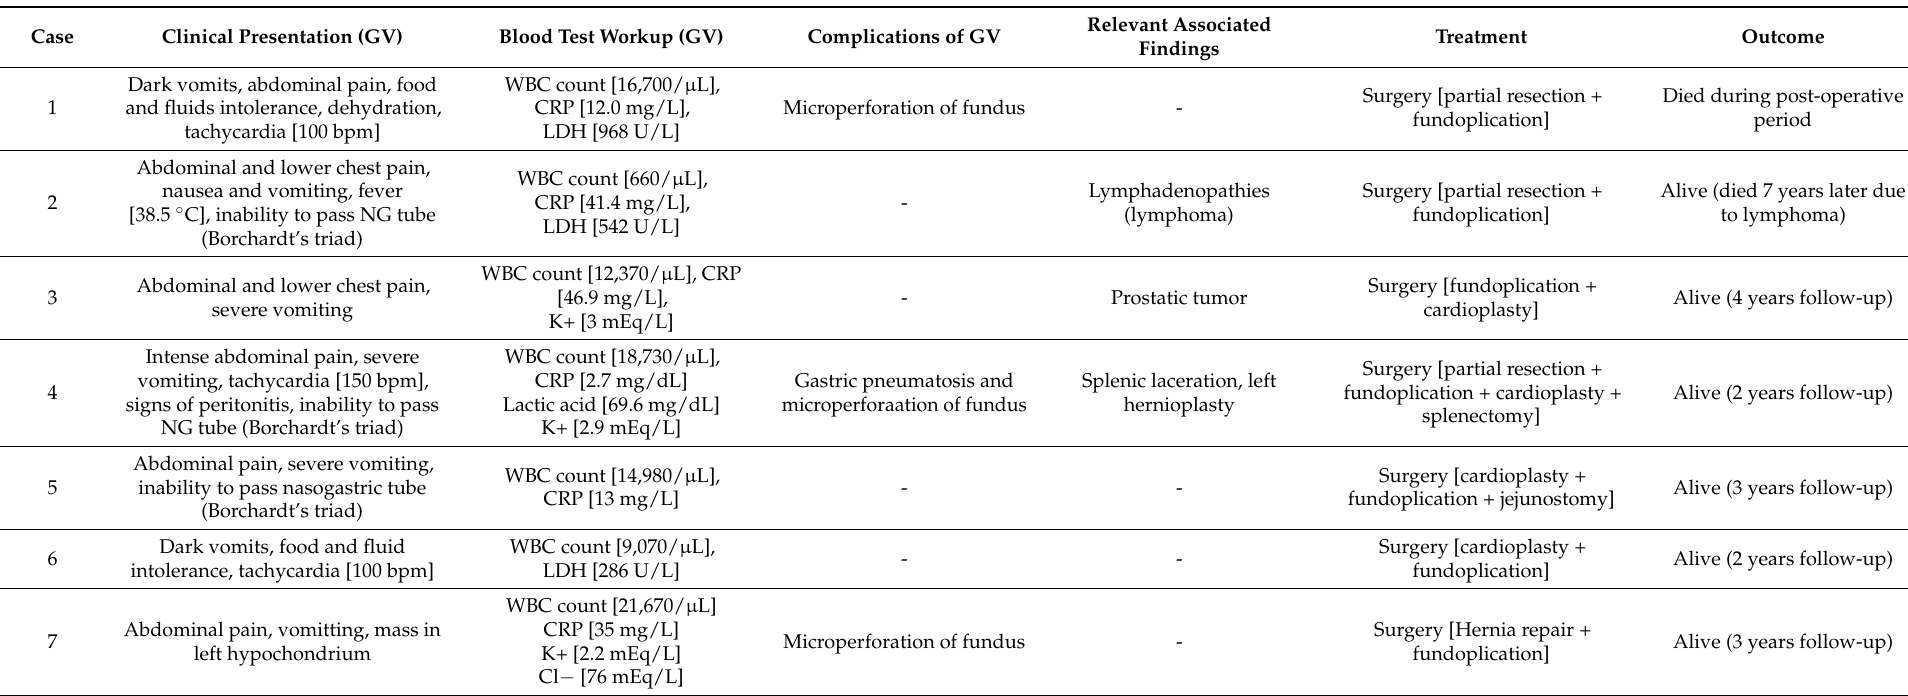
Table 2. Clinical and laboratory parameters at acute presentation, complications and associated findings on imaging, treatment and outcomes of patients in